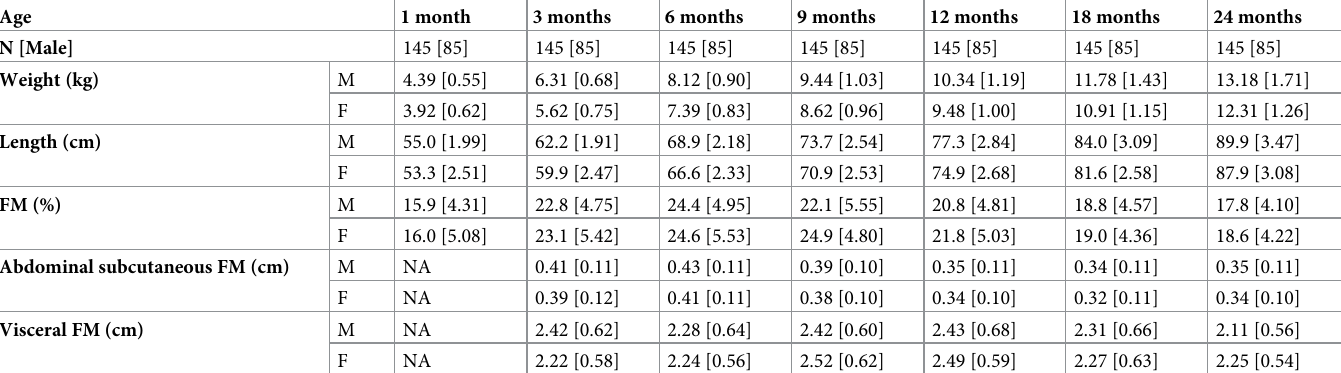
Table 1. Clinical characteristics of boys and